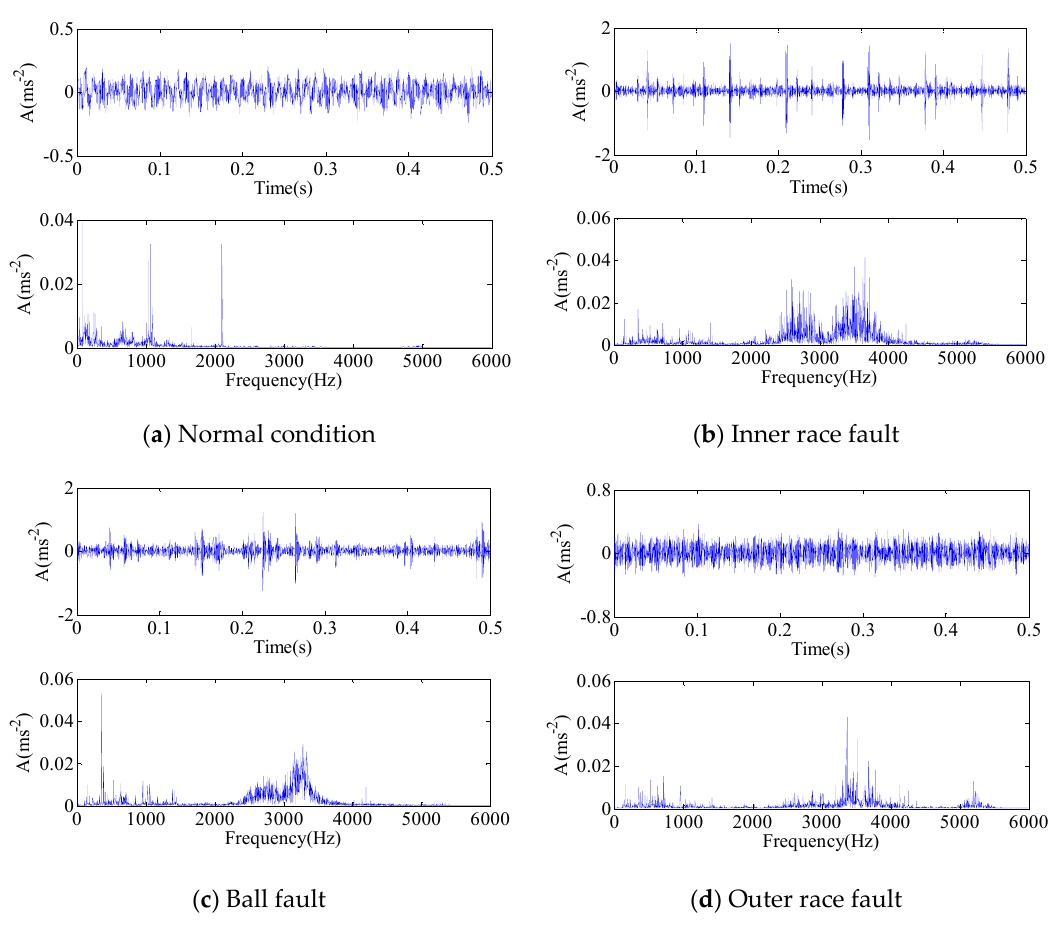
Figure 4. The time waveforms and frequency spectra of vibration signals: ( a ) Normal condition; ( b ) Inner race fault; ( c ) Ball fault; ( d ) Outer race fault.